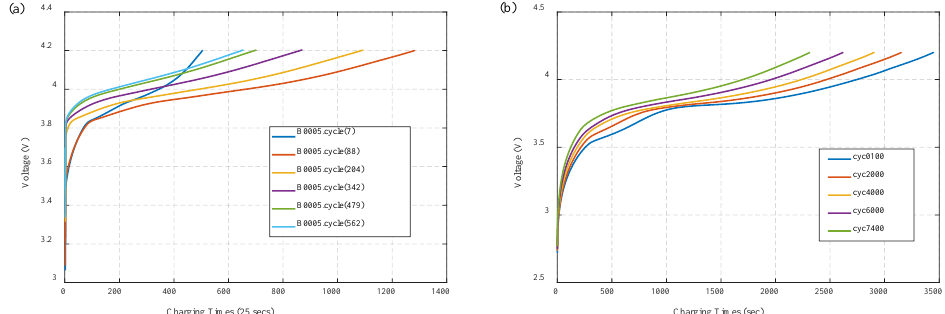
Figure 4. ( a ) Charging curve of di ff erent cycle times in Battery#05. ( b ) Charging curve of di ff erent cycle times in Cell2.